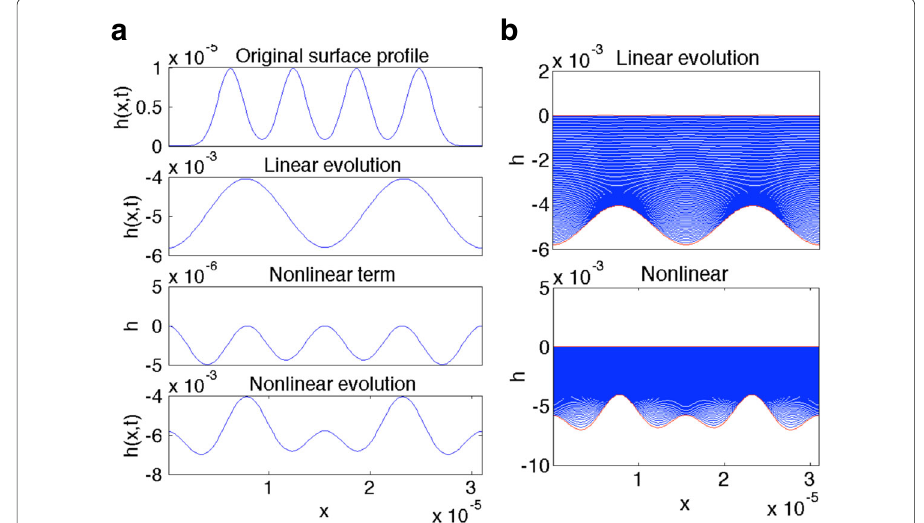
Fig. 6 a Comparison of the initial surface with the final surface profiles under both linear and nonlinear evolution, with nonlinear term plotted to show the wavelength magnitude. The original surface is a series of 4 gaussian bumps. b Evolution of a gaussian bump surface profile using the linear form of the evolution equation ( top ) and nonlinear term included ( bottom ), showing the influence of the nonlinear term. All units shown are in